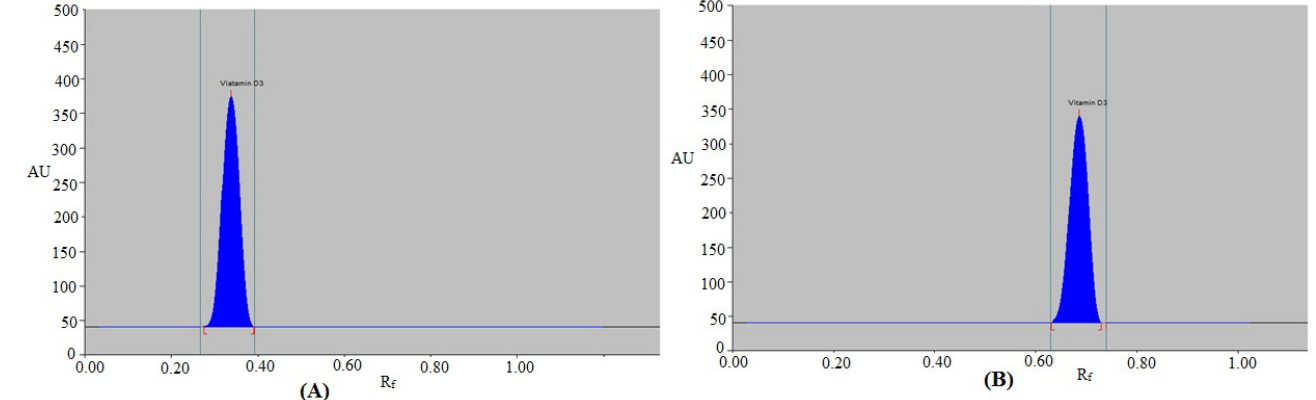
Figure 2. Representative chromatograms of standard VD3 recorded using ( A ) traditional normal- phase HPTLC and ( B ) greener reversed-phase HPTLC methods.